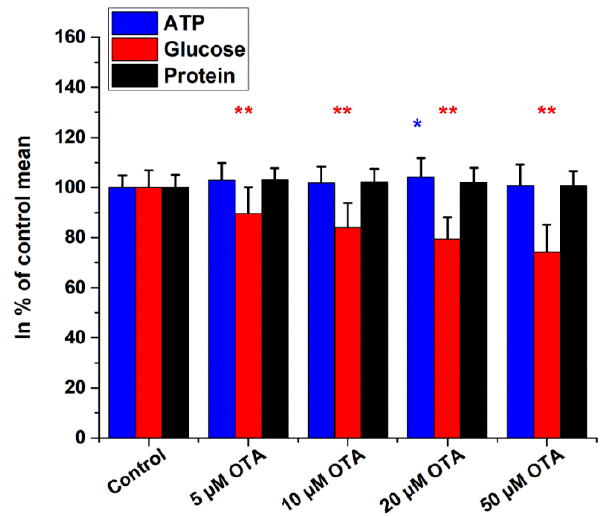
Figure 7. Intracellular glucose, ATP, and protein contents of HepG2 cells treated with ochratoxin A (4 h incubation). Data are expressed as % of control. Bars represent mean ± SD of six independent experiments (* p < 0.05, ** p < 0.01 compared with controls).